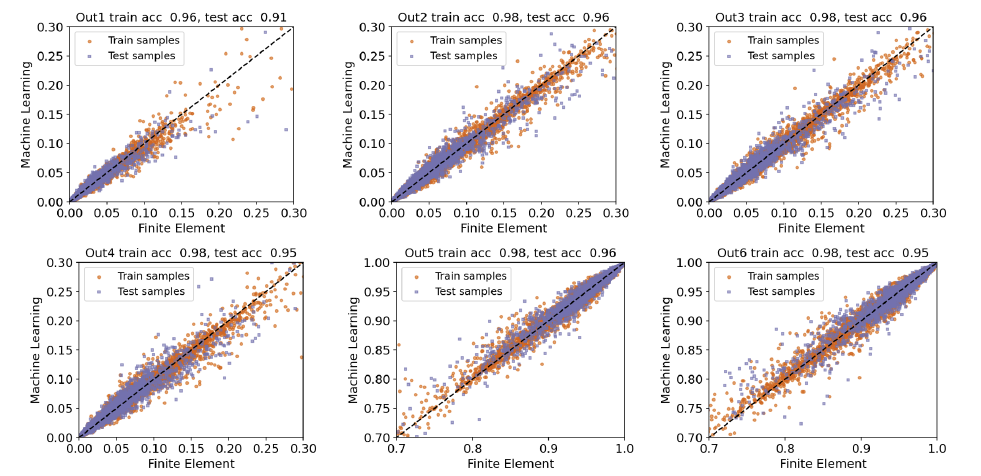
Figure 8. Scenario 2 (Out1 through Out6): plotting true vs. predicted values for both training and test samples. The available data are split into train/test sets according to Figure 1. We see that the surrogate model performs well on both training and test sets, and the R 2 values exceed 0.9 for all the studied